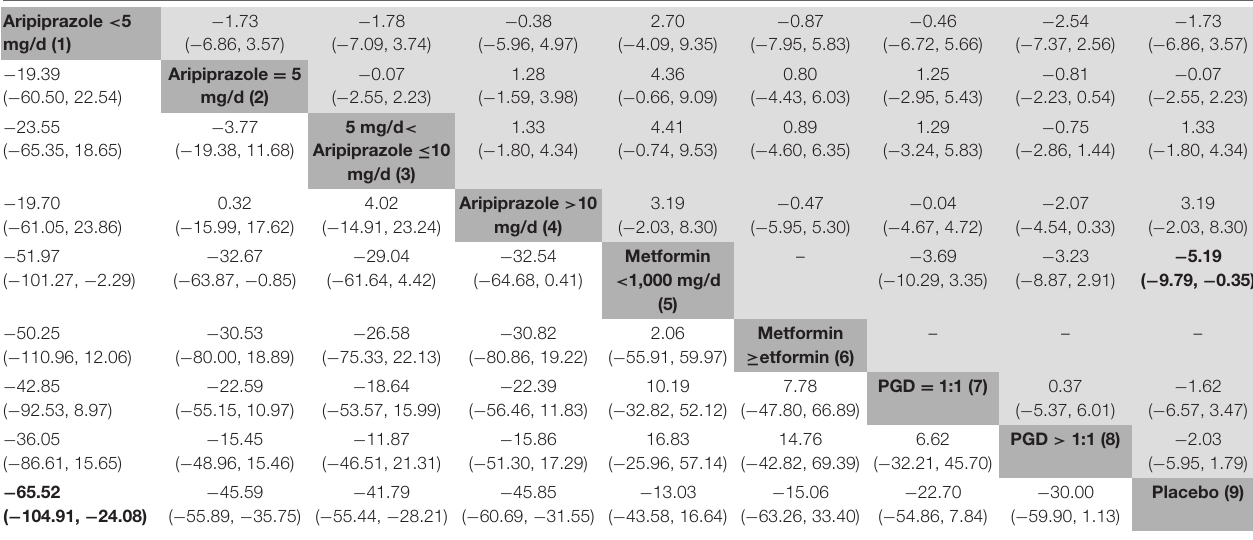
TABLE 2 | Network meta-analysis of adjunctive aripiprazole, metformin, and PGD with regard to the mean changes of prolactin levels and PANSS total scores in schizophrenia [mean differences (95% CI)]. Aripiprazole < 5 mg/d